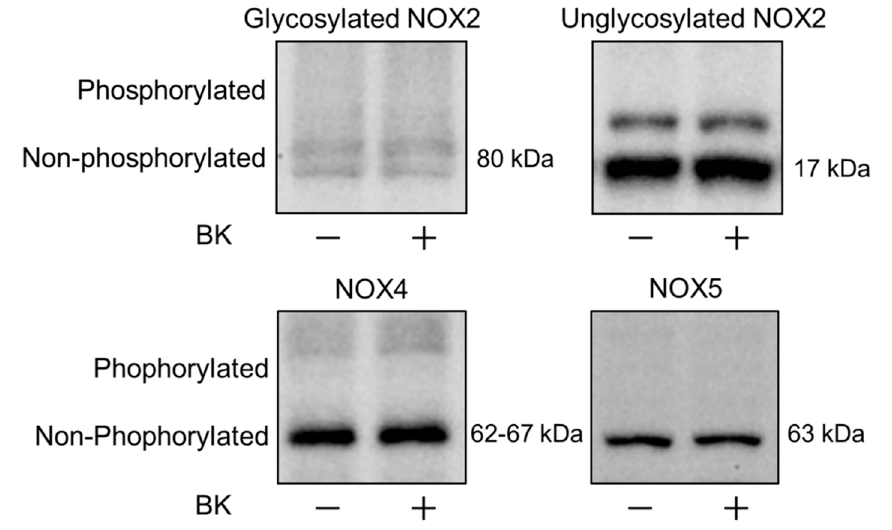
Figure 6. Bradykinin stimuli did not mediate NADPH oxidase 2, 4, or 5. Representative Phos-tag™ SDS-PAGE Western blots of glycosylated NOX2 and unglycosylated NOX2, NOX4, and NOX5. There was no phosphorylation of the core protein of each NOX by BK stimulation.